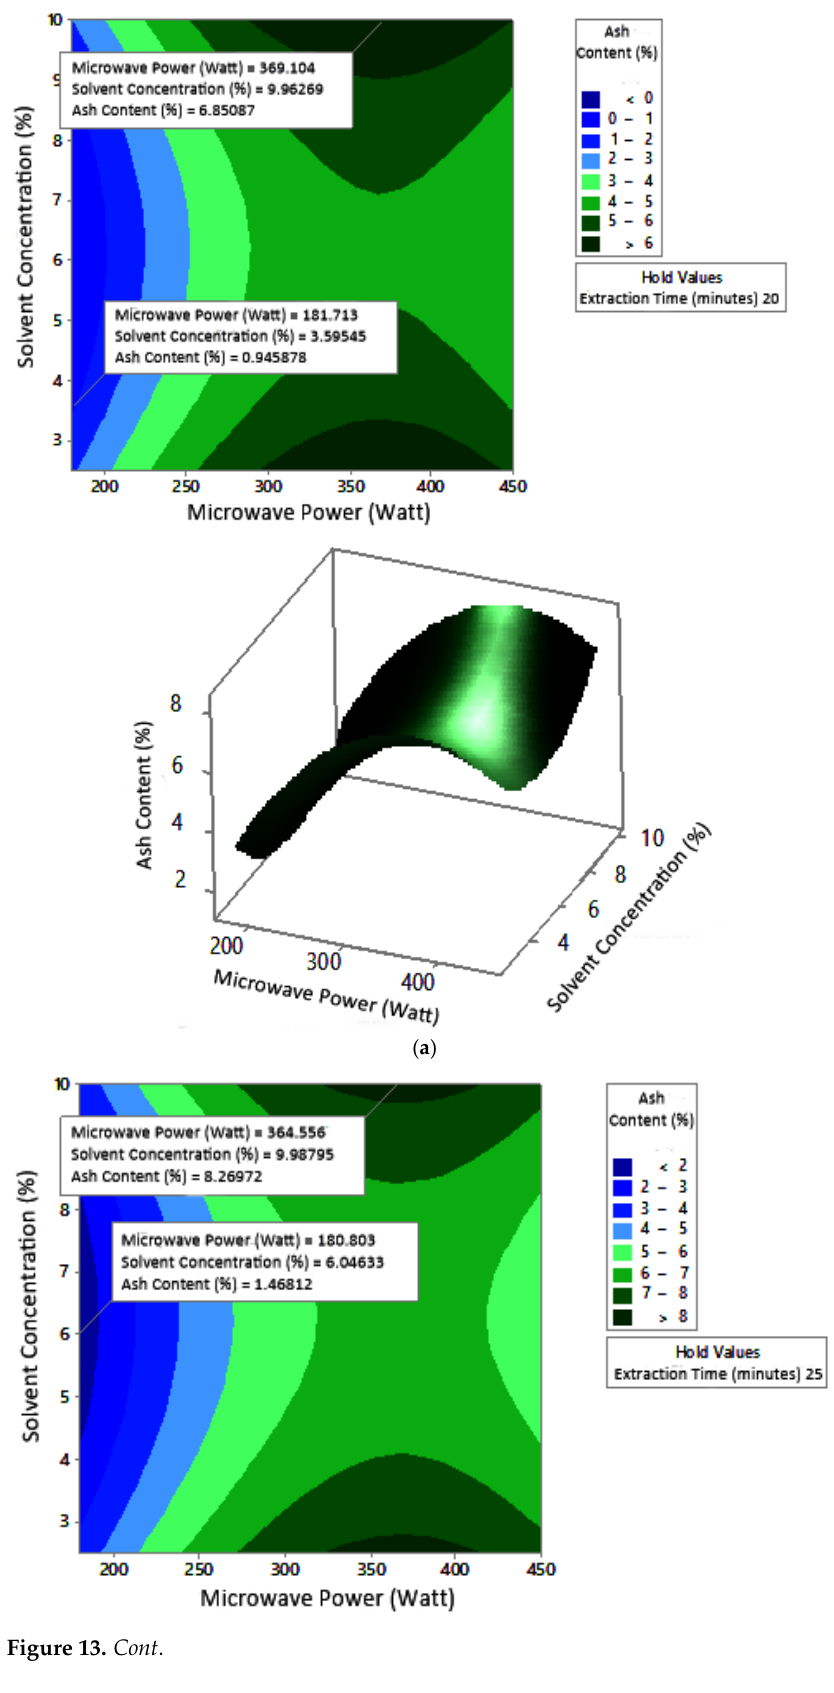
Figure 12. Effect of extraction time and solvent concentration on ash content at microwave powers: ( a ) 180 W, ( b ) 300 W, and ( c ) 450 W.